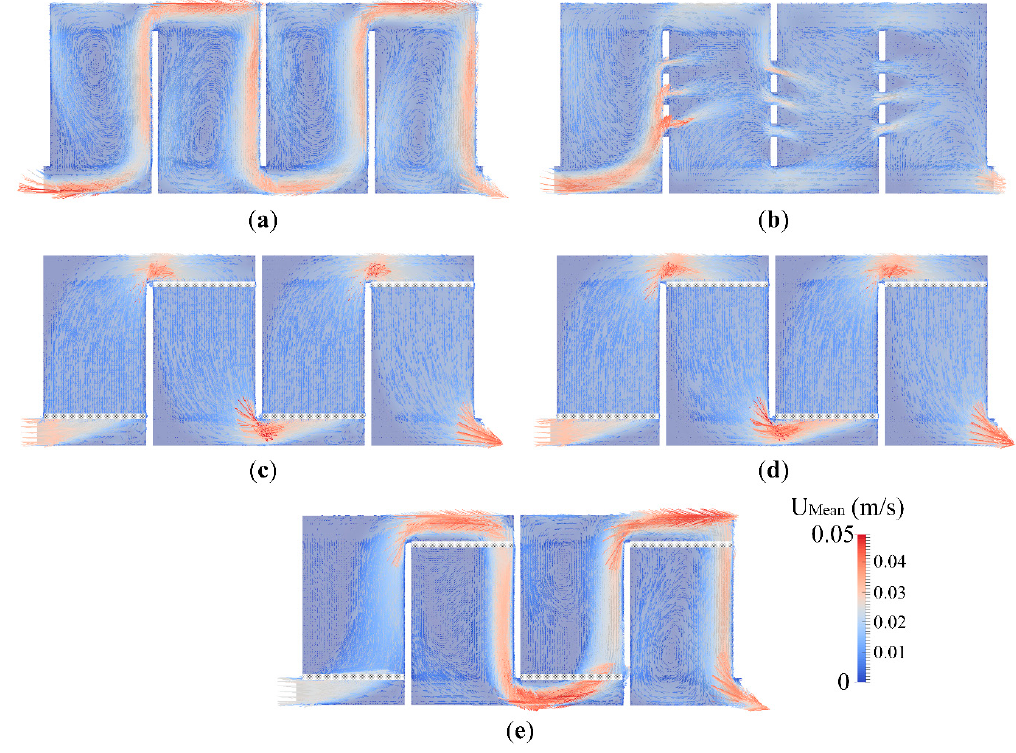
Figure 2. Time-averaged velocity vectors on a vertical plane at the center of the tank: ( a ) Conventional; ( b ) Slot-baffle; ( c ) Porous design 1; ( d ) Porous design 2; and, ( e ) Porous design 3.